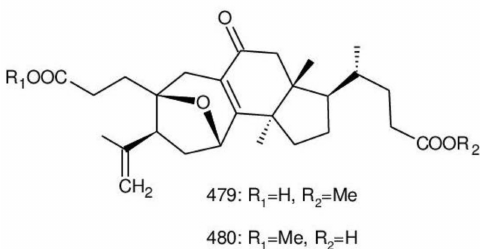
Figure 27. Chemical structures of cochlate A ( 479 ) and cochlate B ( 480 ) as rearranged novel triterpenoids.